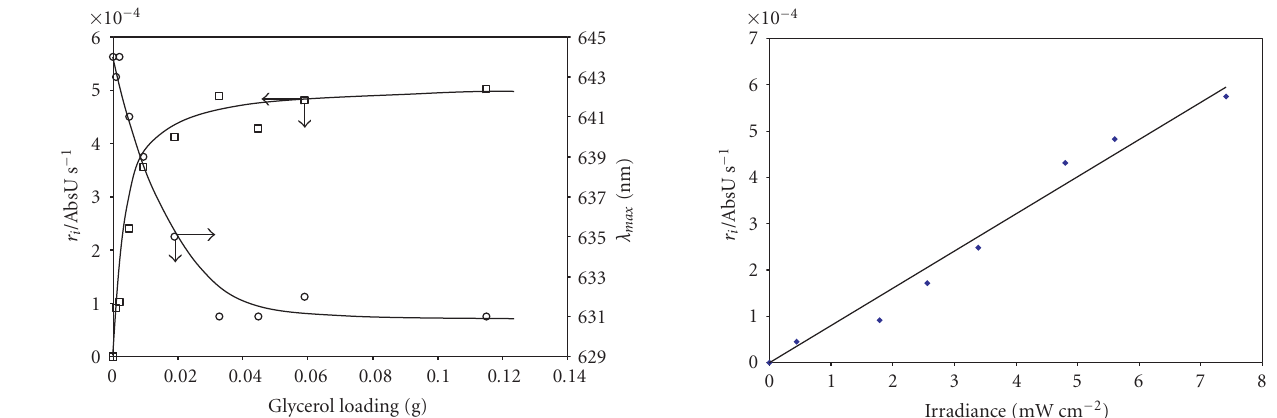
Figure 6: The variation in r i with UVA